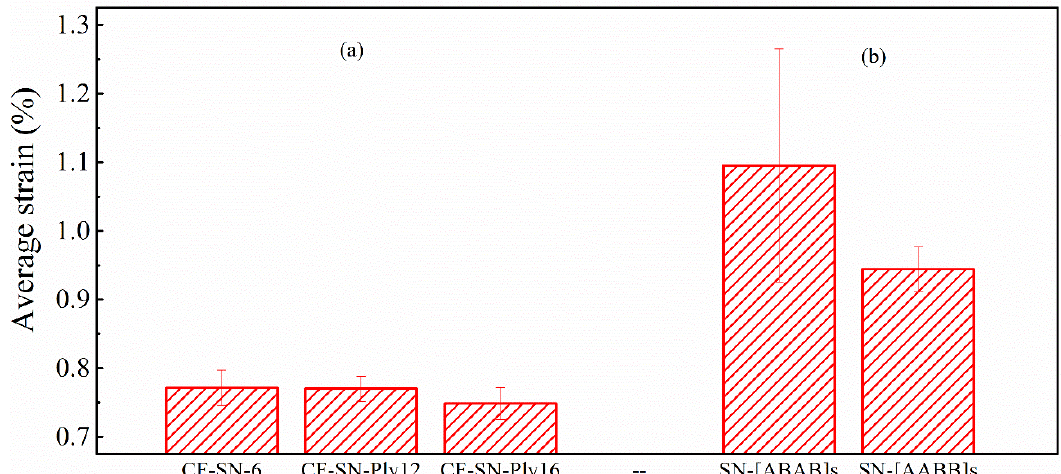
Figure 8. Comparison of the average strain of specimens with different lay ‐ ups. ( a ) Different layer thickness group. ( b ) Different layer sequence group. The degree of strain concentration is relatively small for the orthogonal fabric; the stress concentration at the crack tip of specimen CF ‐ SN ‐ [ABAB]s is more evident than that of specimen CF ‐ SN ‐ [AABB]s (i.e., the average strain of CF ‐ SN ‐ [ABAB]s is higher).